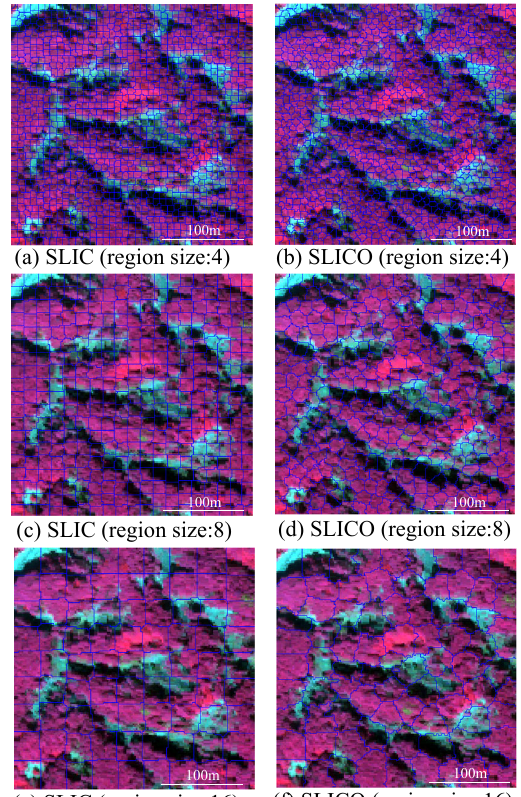
Figure 5. Comparison of segmentation in area 2